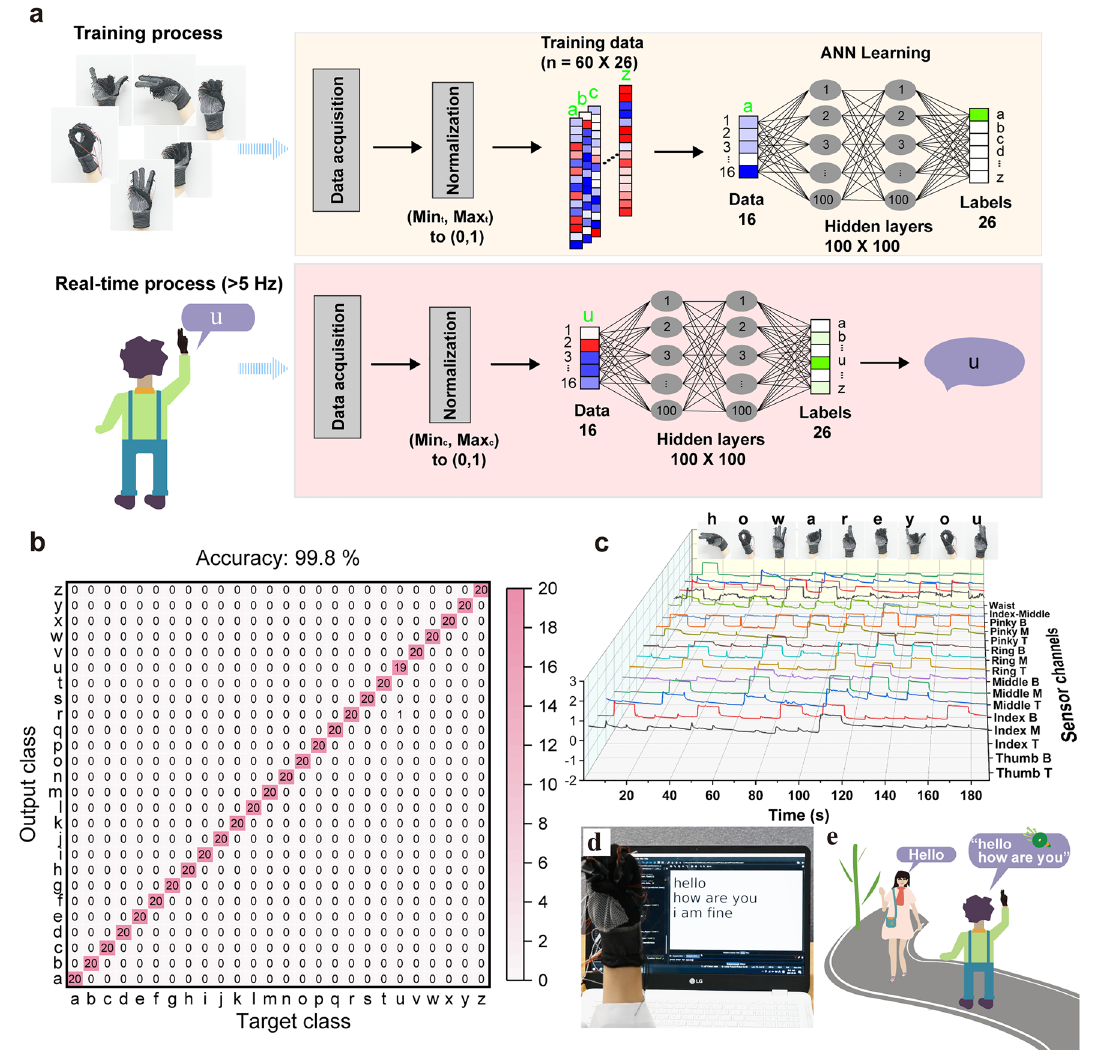
Fig. 5 Deep-learning-enabled all-alphabet sign recognition and real-time dialogue translation. a Training and real-time process of 26-letter- recognition and translation system, and detailed ANN architecture. b Confusion matrix for individual recognition of all letters, exhibiting a high overall accuracy of 99.8%. c Collected real-time-normalized data when a continuous dialogue sign “how are you” is demonstrated. d Experiment showing the input sentence in real time from the sign language demonstrated by the volunteer wearing the smart glove. e Illustration showing a signer communicating with a person with the help of the sign-language translation